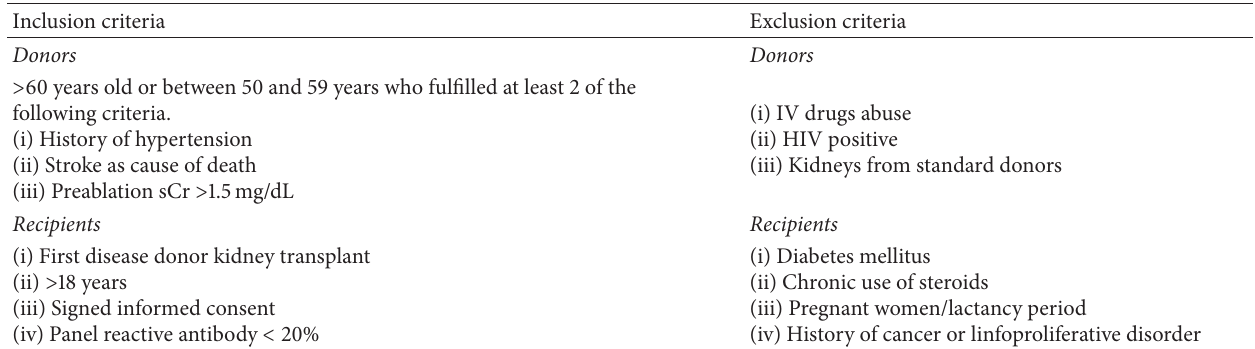
Table 1: Inclusion and exclusion